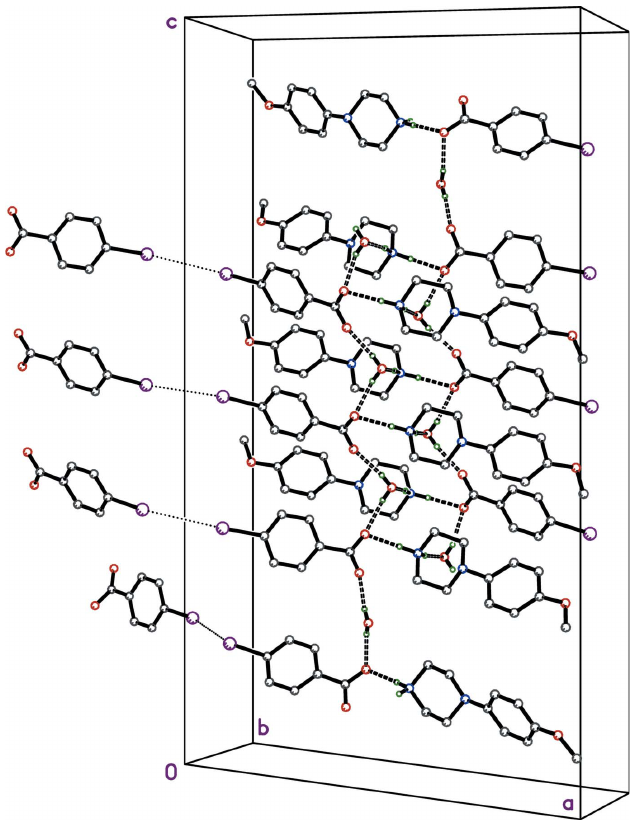
Figure 7 A partial packing plot of II viewed down the b -axis showing a slice through the N—H (cid:2)(cid:2)(cid:2) O (solid dashed lines) and O—H (cid:2)(cid:2)(cid:2) O (open dashed lines) hydrogen-bonded double layers. Thin dashed lines indicate (cid:2) – (cid:2) stacking of cation and anion arene rings. Hydrogen atoms not participating in hydrogen bonds are omitted.